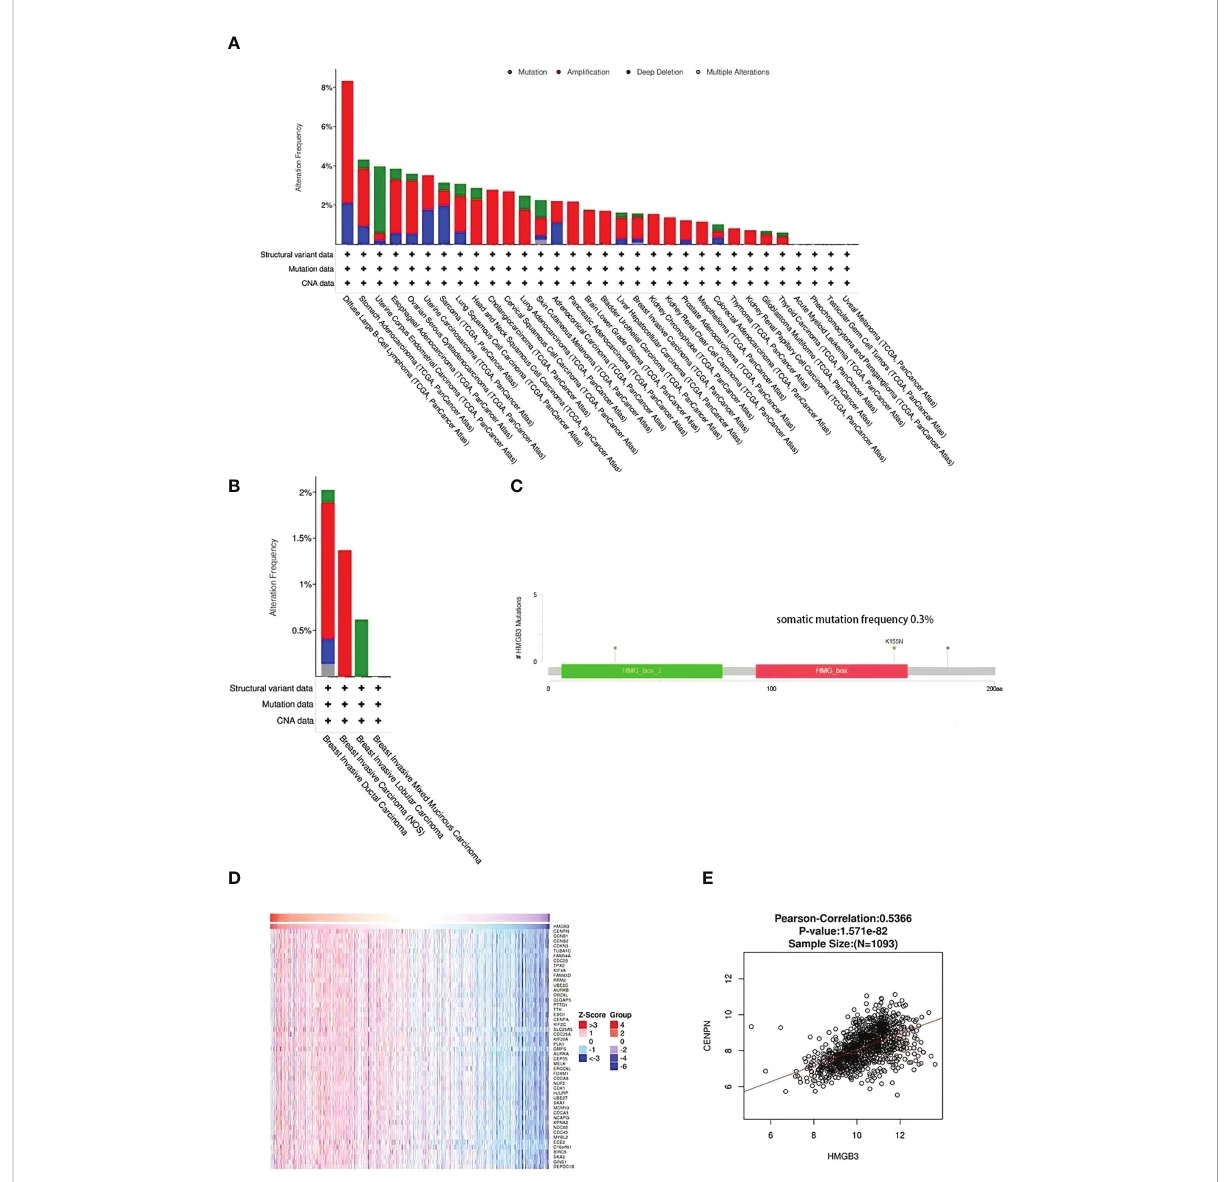
FIGURE 6 HMGB3 coexpression and mutational characteristics in breast cancer. (A) Pan-cancer frequency variations due to HMGB3 mutation type. (B) The frequency and kind of HMGB3 genetic alterations found in various breast cancer types. (C) Analysis of breast cancer HMGB3 mutations. (D) The heap maps highlight the genes that have a positive correlation to HMGB3 in breast cancer. (E) LinkedOmics database analysis of the relationship between HMGB3 and CENPN expression in breast